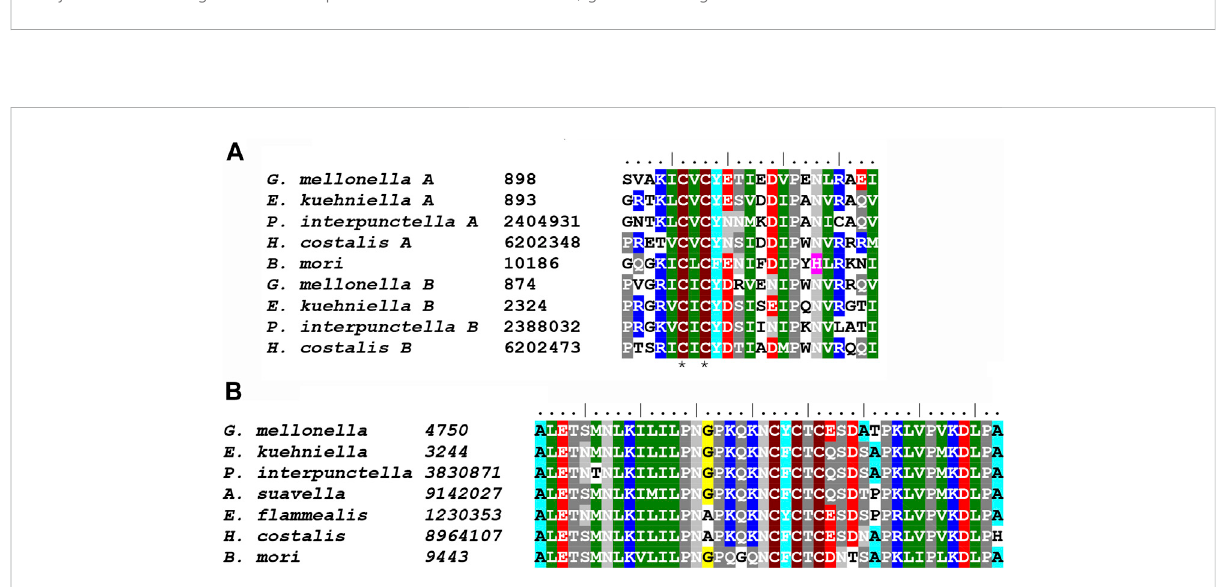
FIGURE 6 (A) Multiple sequence alignment of Ser1 C-terminal sequences containing conserved CXCX motif: G. mellonella Ser1A (MG770315), E. kuehniella Ser1A (ON604817) P. interpunctella Ser1A (JAJAFS010000011.1), H. costalis Ser1A (OW443355.1), B. mori Ser1 (XM_038013610.1), G. mellonella Ser1B (XM_031911923), E. kuehniella Ser1B (ON604818), P. interpunctella Ser1B (JAJAFS010000011.1), H. costalis Ser1B (OW443355.1). Conserved cysteine residues are marked with asterisks. (B) Multiple sequence alignment of Muc1 C-terminal sequences containing conserved CXCXCX motif: G. mellonella (MG770312.1), E. kuehniella (ON604821), P. interpunctella (JAJAFS010000011.1), A. suavella (OW971956.1), E. fl ammealis (LR990879.1), H. costalis (OW443355.1), B. mori (XM_021350004.2). Conserved cysteine residues are marked with